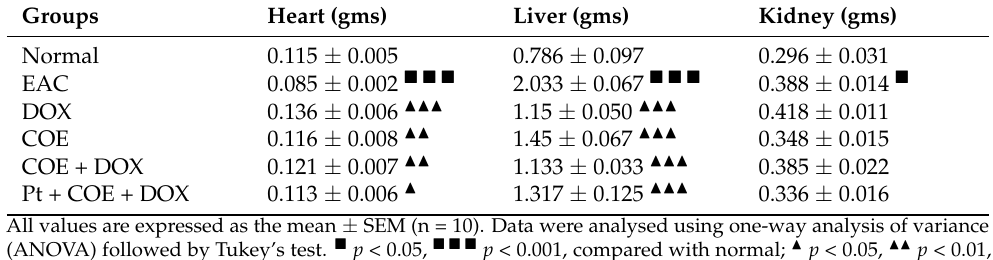
Table 1. Effect of COE on organ weight .